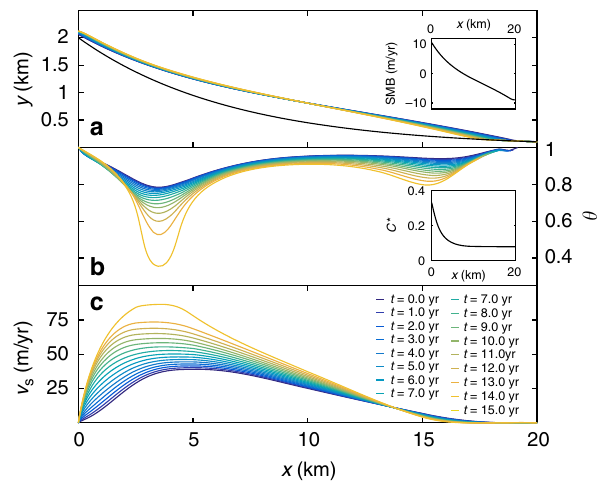
Fig. 2 Evolution of topography, basal friction and surface velocities during the quiescent phase. a Evolution of the glacier geometry in time. Inset: the prescribed surface mass balance (SMB) is a function of elevation, here plotted as a function of x using the initial glacier geometry. b Evolution of the state parameter θ . Inset: the peak friction coef fi cient C (cid:3) ¼ C σ N σ in Supplementary Information) as a function of x . c Evolution of surface velocity. Simulation using q = 1.5 and d c = 1.5